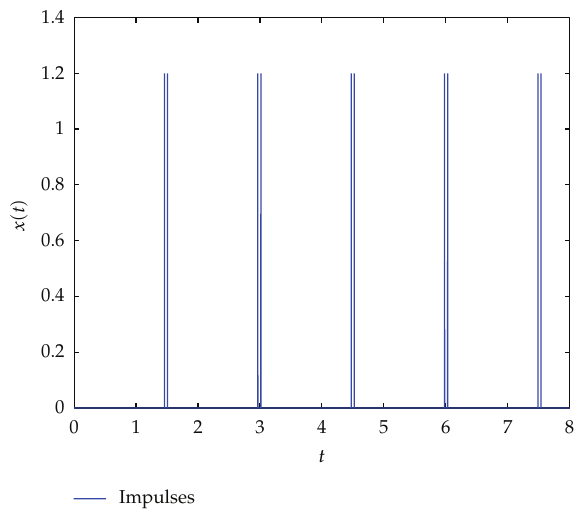
Figure 1: Impulses of Example